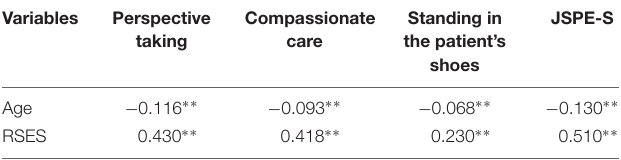
TABLE 3 | Correlation analysis between empathy and self-esteem.